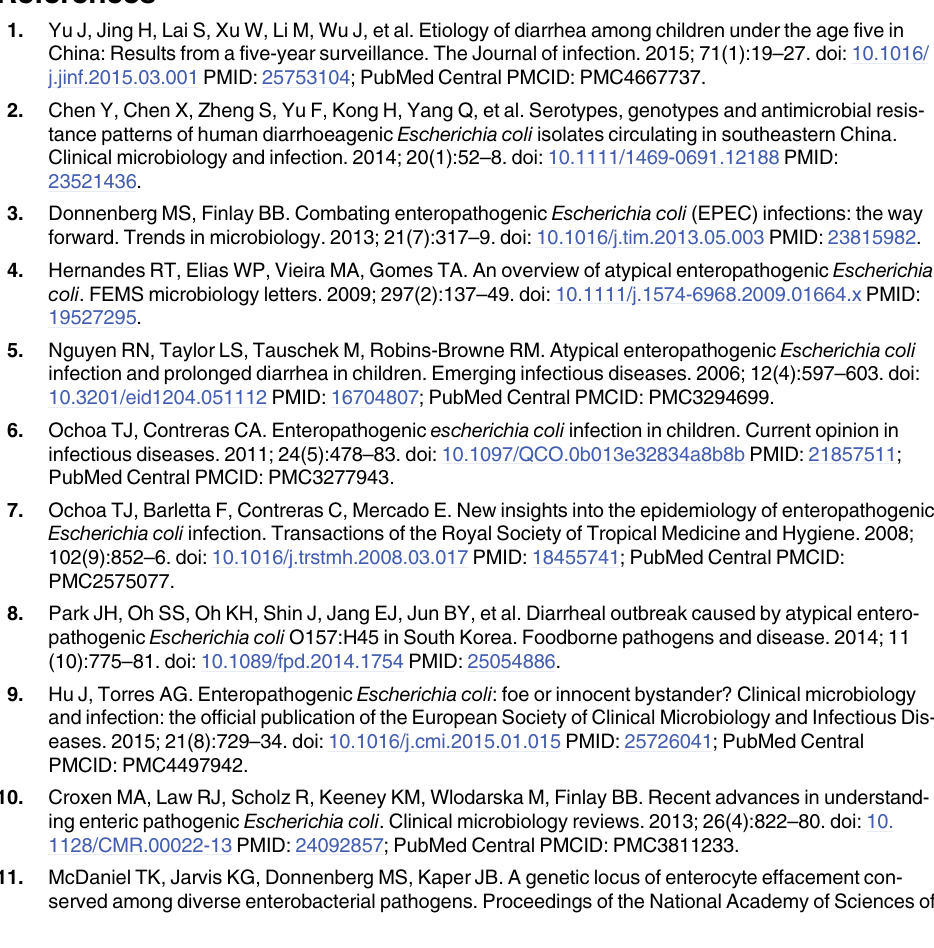
S1 Table. Intimin subtypes and GenBank accession numbers of the 143 aEPEC strains used in this